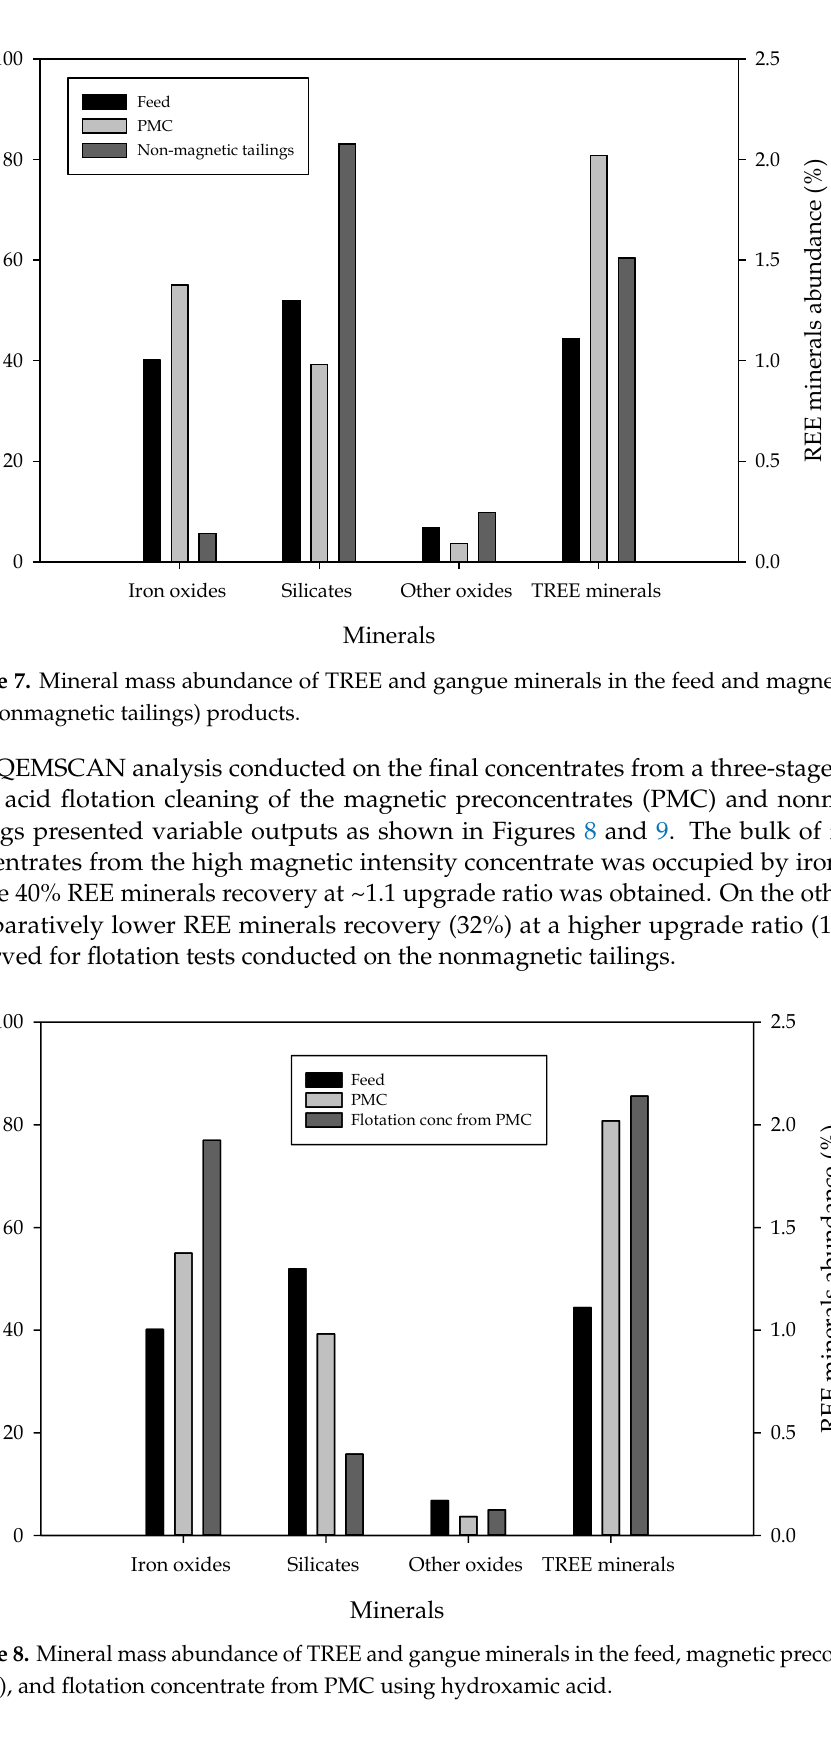
Figure 9. Mineral mass abundance of TREE and gangue minerals in the feed, non-magnetic tailings, and flotation concentrate from non-magnetic tailings using hydroxamic acid. 3.7. REE Minerals Grade – Recovery Relationship Figure 10 illustrates the grade – recovery relationship in selected separation products obtained from the various beneficiation tests. The best concentrate grade (3.7%) was ob- tained during the tabling process, where REE minerals recovery (29%) was the lowest. The corresponding silicate content in the tabling concentrate was significantly low; however, the high iron oxide content (Table 4) is undesirable. On the other hand, where REE min- erals recoveries were higher (≥30%), the corresponding concentrate grades were compar- atively lower. In terms of recovery, the best result was achieved during the multistage flotation process in the presence of hydroxamic acid and depressants, but a number of challenges have been identified with the process. For example, hydroxamates are expen- sive and characterized by a high consumption rate. Furthermore, the high silicate content (62.13%) in the flotation concentrate would need to be reduced, possibly by introducing a desliming stage, to remove fine/ultrafine silicates, which are easily recovered via entrain- ment. In addition, regrinding of the feed or selected flotation products to promote REE – gangue minerals liberation may be considered.